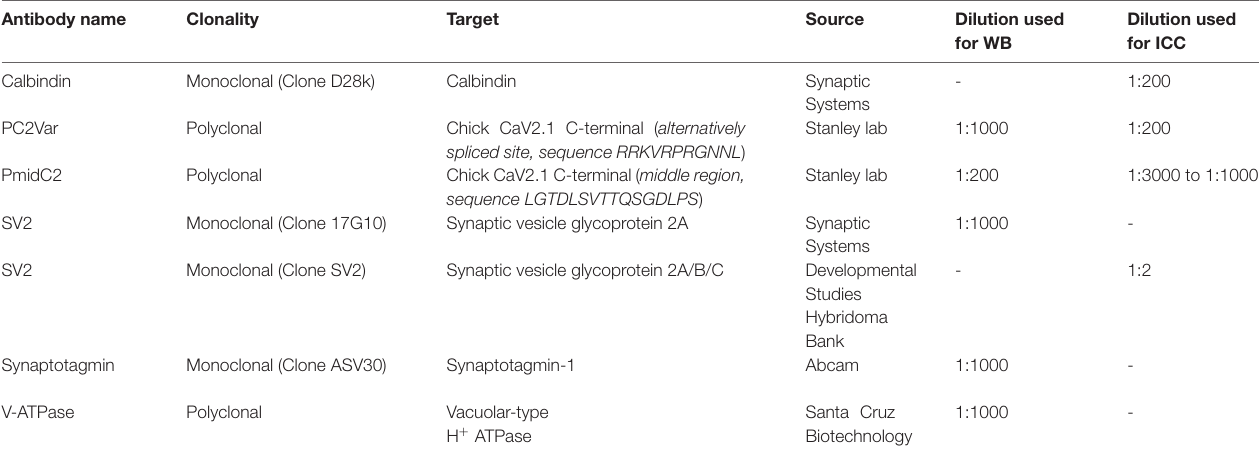
TABLE 1 | List of Antibodies used in this